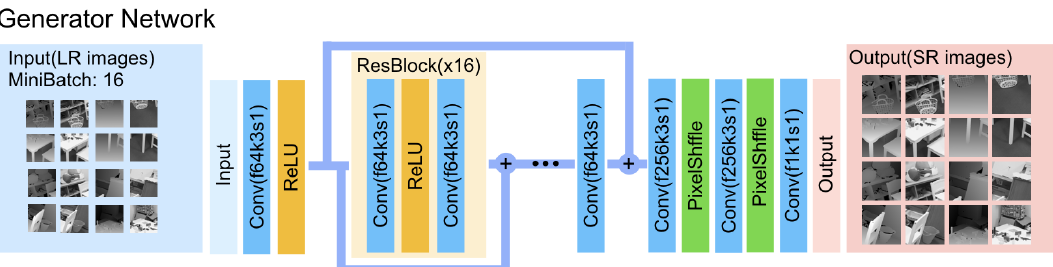
Figure 3. Generator network of the proposed generative adversarial network framework for depth map super-resolution with f: the number of feature maps, k: the kernel size, and s: the stride indicated for each convolutional layer.